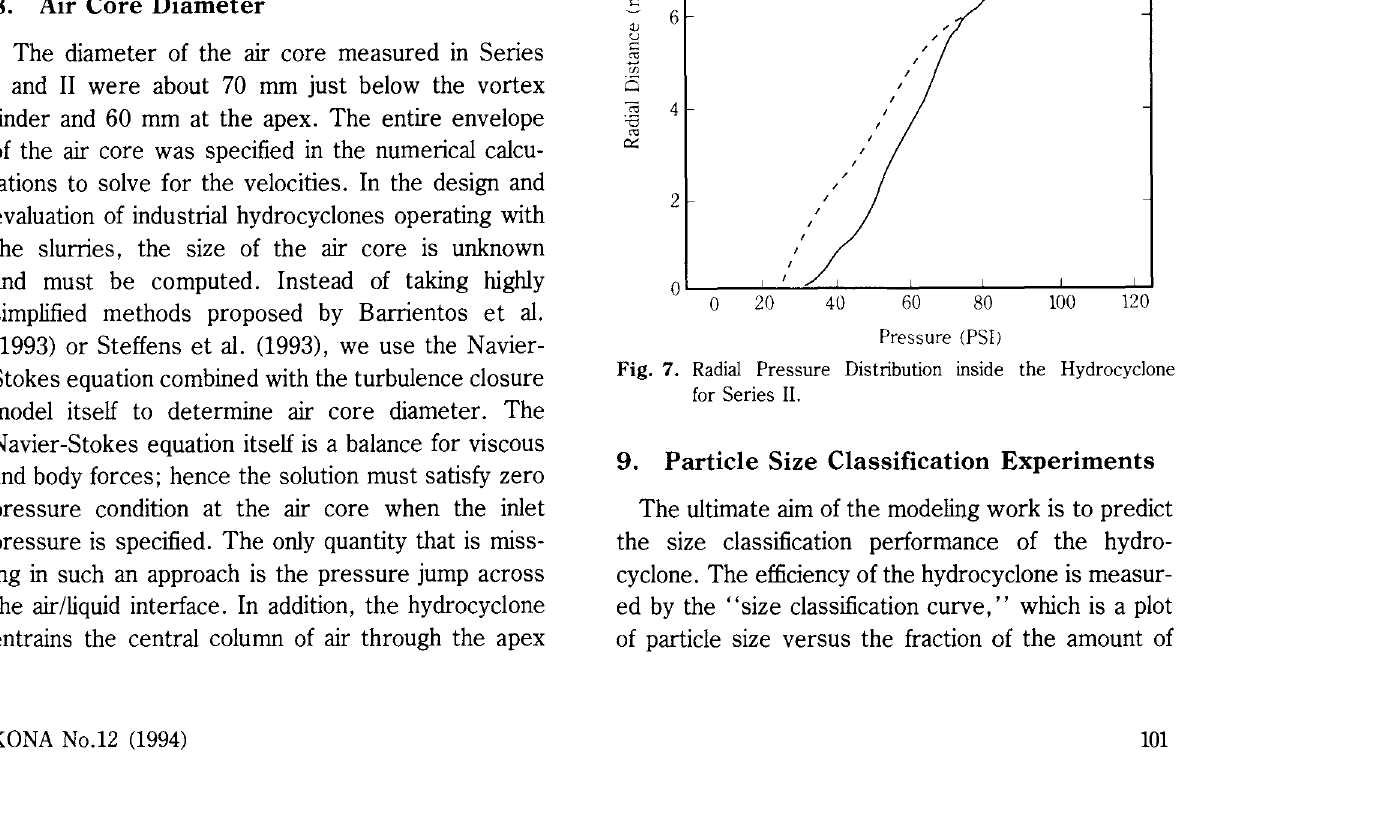
Fig. 7. Radial Pressure Distribution inside the Hydrocyclone for Series